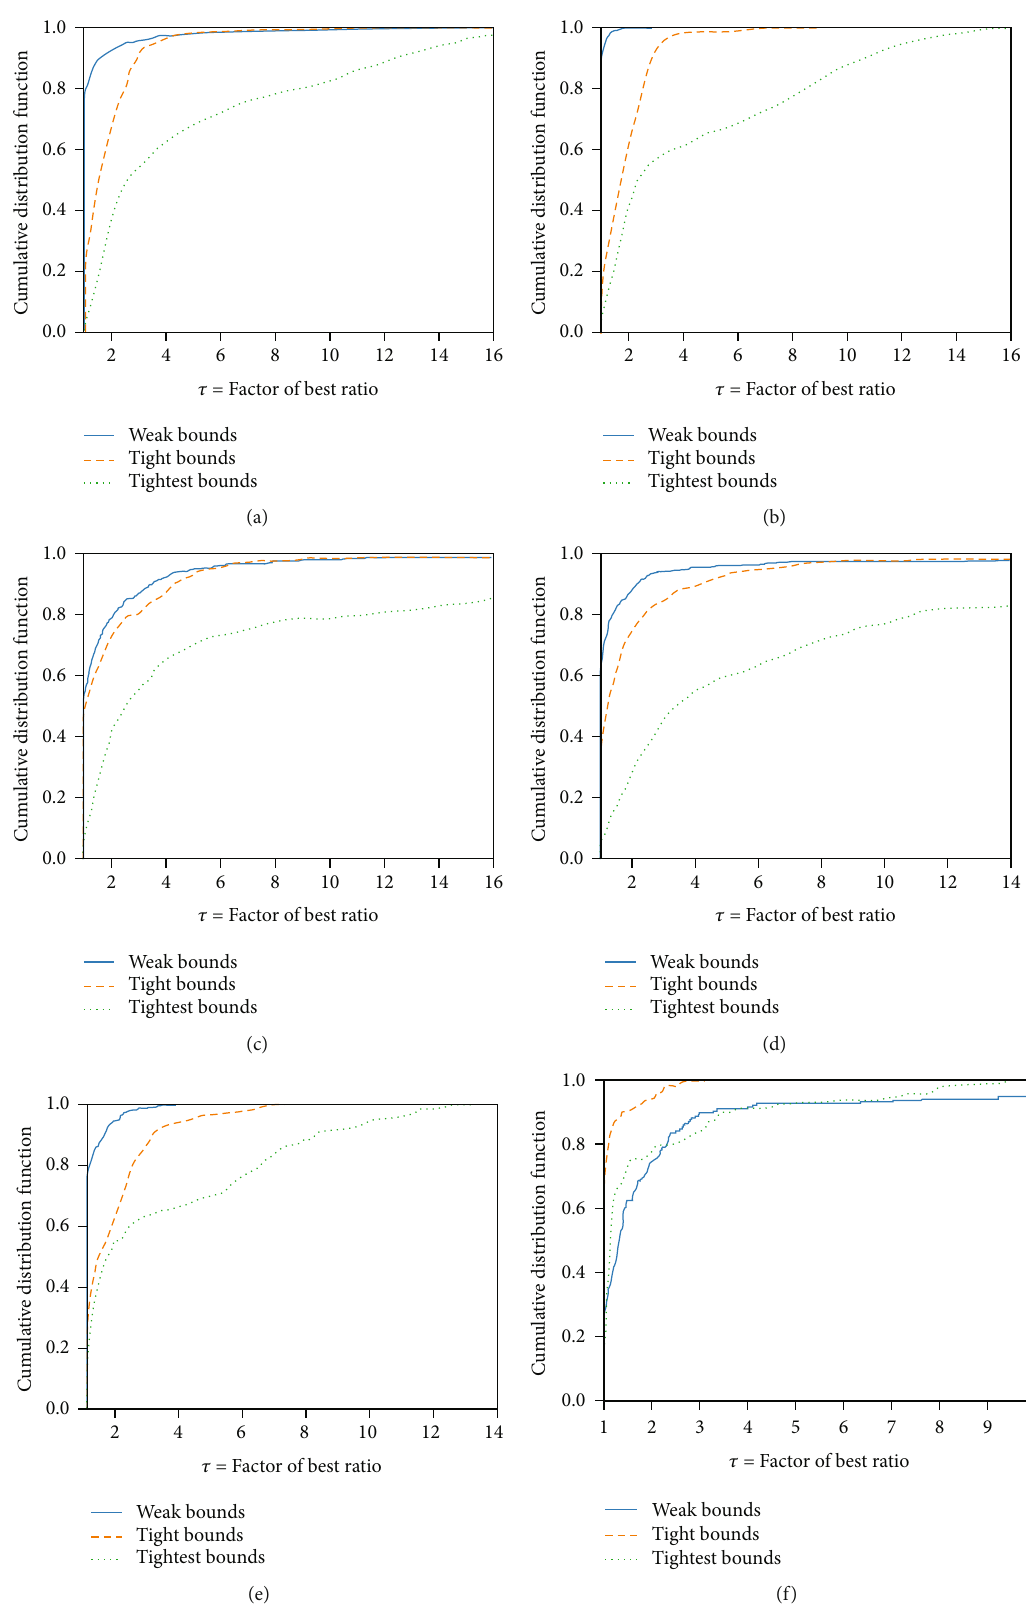
Figure 7: Performance pro fi les based on relative CPU time (s) for Question 3. (a) QMKP with positive coe ffi cients, (b) QMKP with mixed- sign coe ffi cients, (c) k QKP with positive coe ffi cients, (d) k QKP with mixed coe ffi cients, (e) HSP, (f)